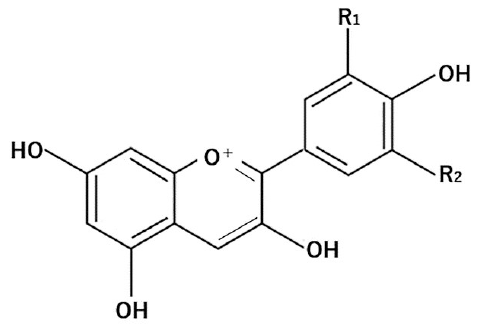
Figure 4. General structure of anthocyanins .